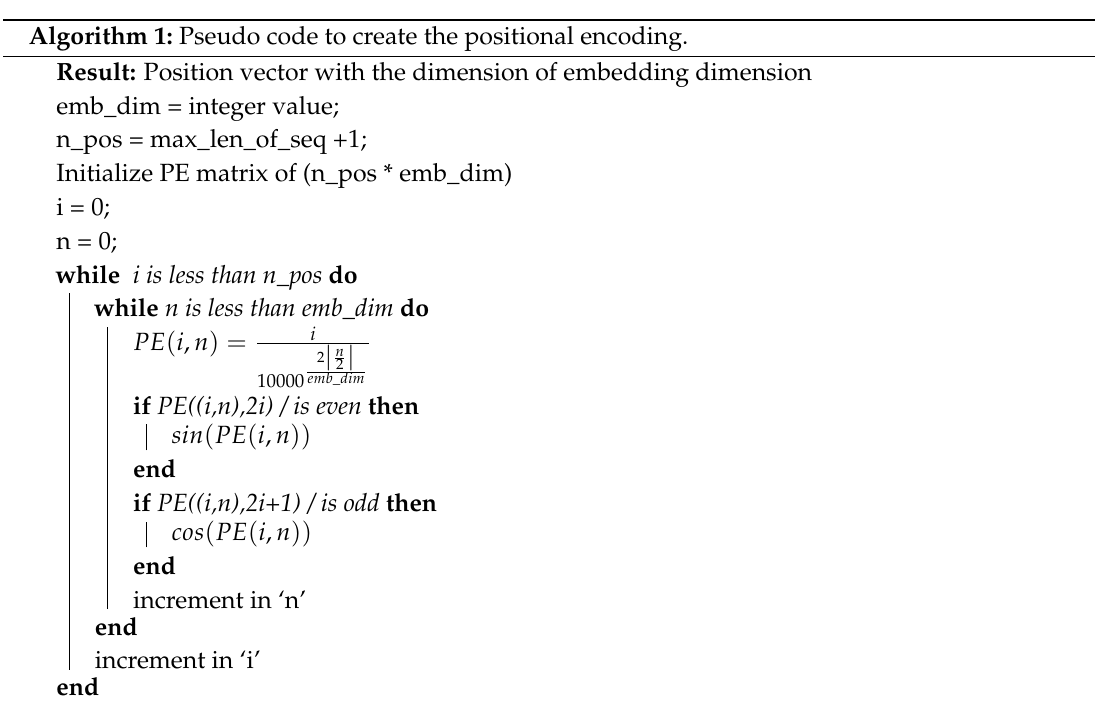
Figure 3. Tracking K-mer positions in terms of binary